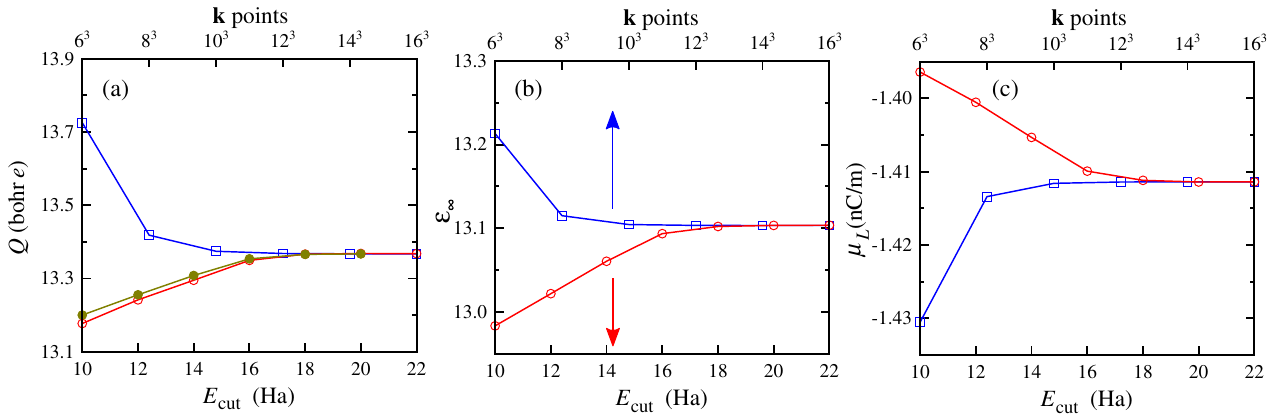
FIG. 2. Convergence of selected linear-response quantities with respect to the plane-wave cutoff and the density of the k -point mesh. Calculated dynamic quadrupole moment (a), dielectric constant (b) and longitudinal flexoelectric coefficient (c) are shown. Red empty circles (lines are a guide to the eye) are obtained by varying the plane-waves energy cutoff while keeping the 12 × 12 × 12 k -points grid fixed. Empty blue squares correspond to varying the k -points mesh resolution with a fixed energy cut-off of 20 Ha. Panel (a) includes the energy cut-off dependence of the quadrupole constant as calculated from the second moment of the induced charge density response (green circles).